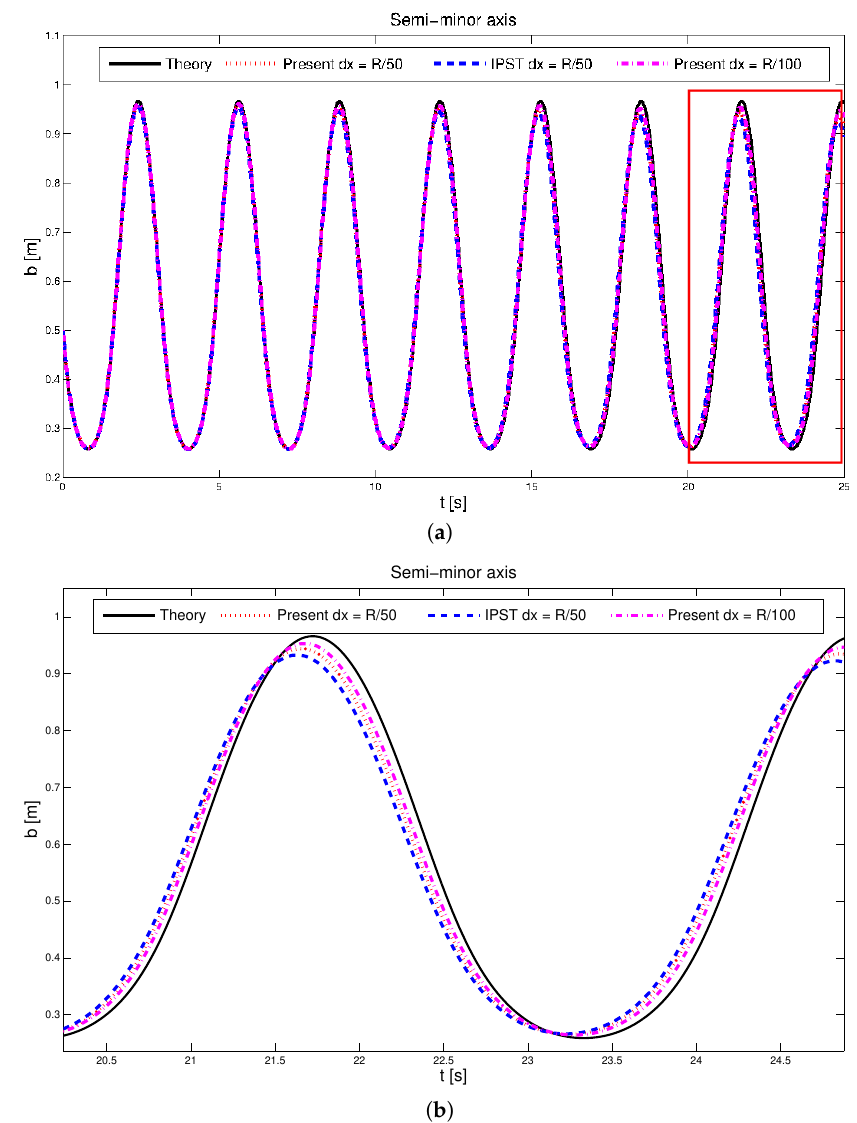
Figure 9. Oscillating droplet under a central conservative force field: Vertical semi minor axis evolution in time b ( t ) . The black solid line presents the theoretical results obtained by solving the system (18) [60]. The red dotted line represents the results obtained by the present particle shifting formulation for the fluid droplet of resolution dx = R , whereas for the magenta dash-dot line is for dx = R . The blue 50 100 dashed line represents the results obtained by the particle shifting technology (IPST) proposed by Wang et al. [37]. The bottom part ( b ) of the figure represents the zoom of selected red rectangle in ( a